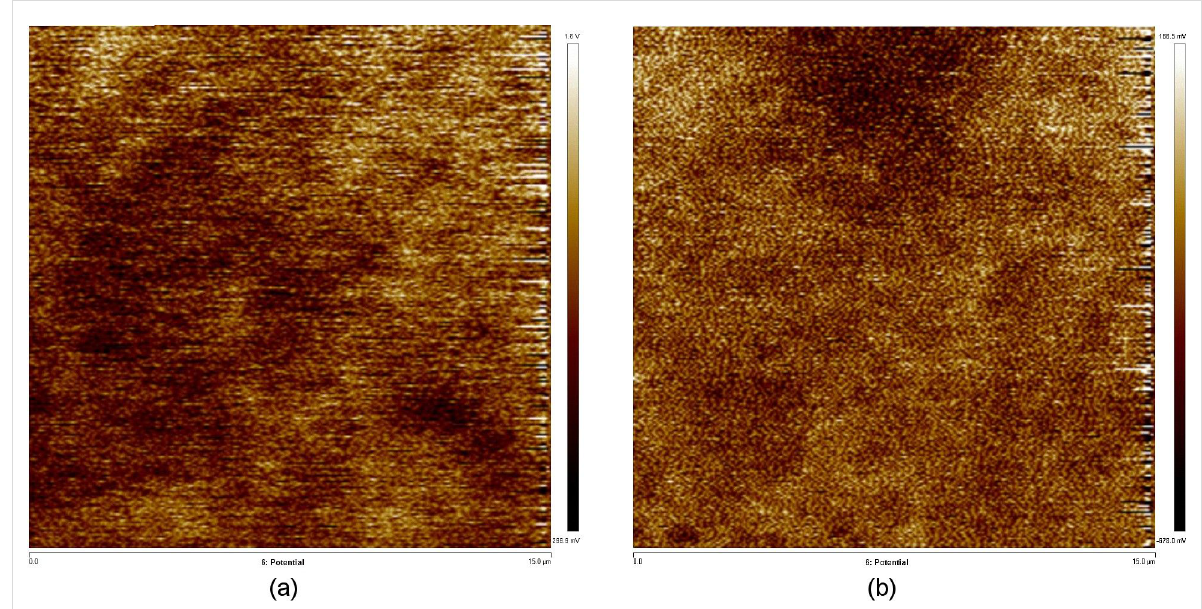
superhydrophilic. For example, at 2000 V and 150 °C, the con- tact angle of the coating changed from 150.5° to 40° after 1 min. Only when the charging time is increased, such as at 2 min, will the coating achieve superhydrophilicity. The dura- bility of the obtained superhydrophilicity of the coating varied with charging time. These results are presented in Figure